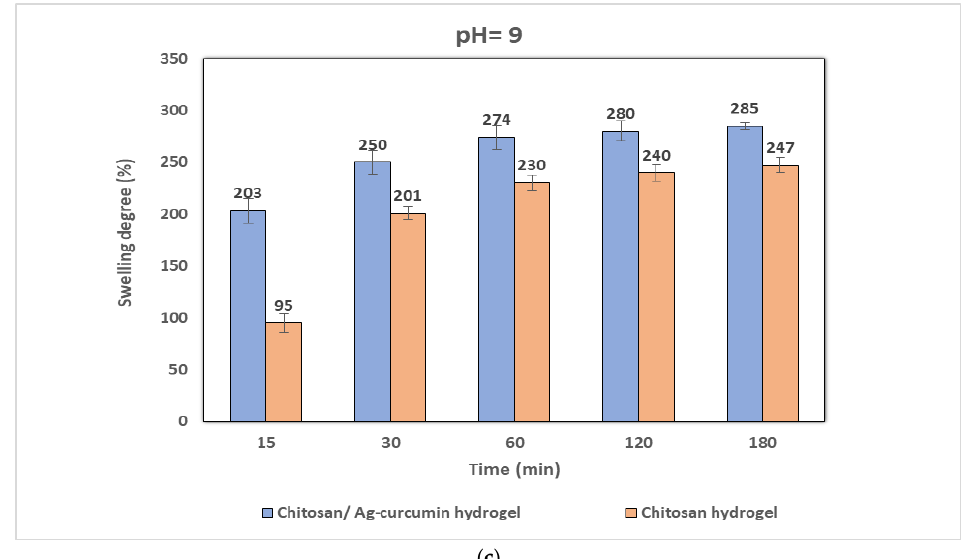
Figure 3. Swelling degree of hydrogel samples in respect of different ( a ) pH 4 ( b )pH 7, and ( c )pH 9.